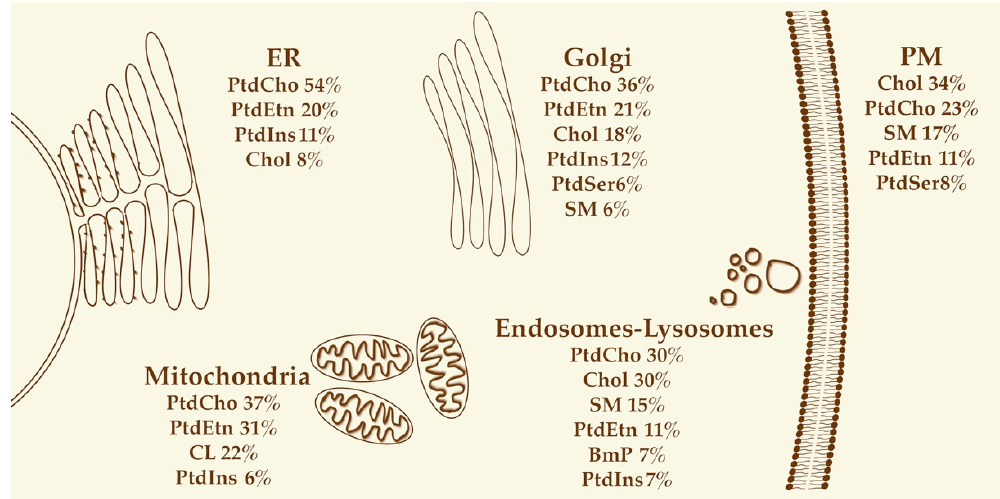
Figure 2. Lipids in organelle identity. For each organelle, the main lipid components are listed according to their contribution to the total lipid content of the organelle (in percentage, from the most abundant to the least abundant). Only lipids representing at least 5% of the total lipids for each organelle are shown. BmP: bis(monoacylglycero)phosphate; Chol: cholesterol; CL: cardiolipin; PtdCho: phosphatidylcholine; PtdEtn: phosphatidylethanolamine; PtdIns: phosphatidylinositol; PtdSer: phosphatidylserine; SM: sphingomyelin. Not to scale. Adapted from [19].